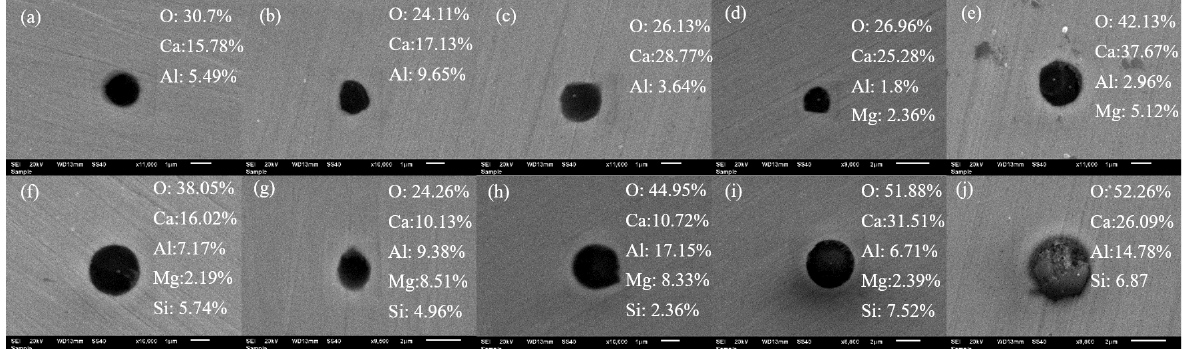
Figure 8. Morphology of inclusions in electroslag ingots prepared with Al2O3-free slag. ( a – c ): Ca-Al-O inclusions; ( d , e ): Ca-Al-Mg-O inclusions; ( f – i ): Ca-Al-Mg-Si-O inclusions; ( j ): Ca-Al-Si-O inclusion. Figure 9 shows the composition and morphology of inclusions in the electroslag ingot prepared by 30 wt%Al 2 O 3 -70 wt%CaF 2 slag. Given that the number of sulfides was 6.5% of the total amount of inclusions, only oxide inclusions were analyzed.